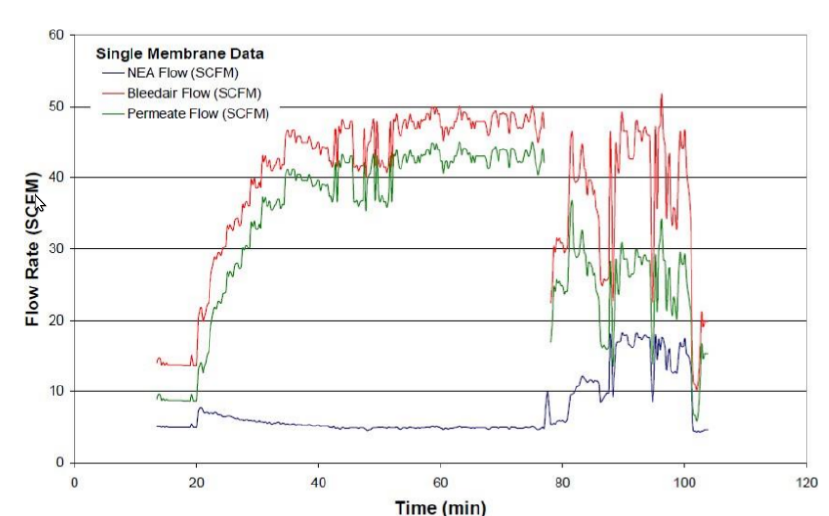
Figure 7. Involved mass flow for the single membrane (only one inerting generator working) flight test. The cruise phase (stabilized flight) is obtained at t = 40 min and the descent phase starts at t = 78 min (source